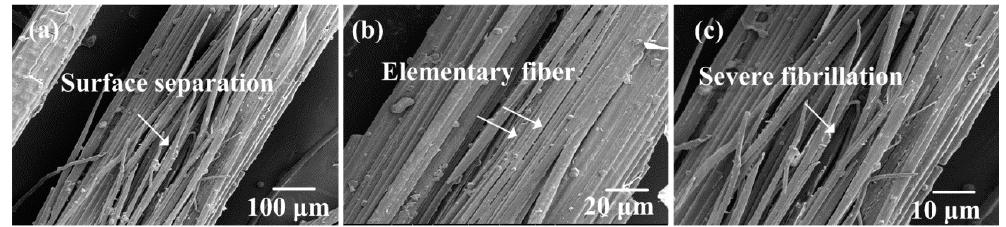
Figure 7. SEM images of the surface of the 10 wt.% NaOH-treated bamboo fiber bundles.